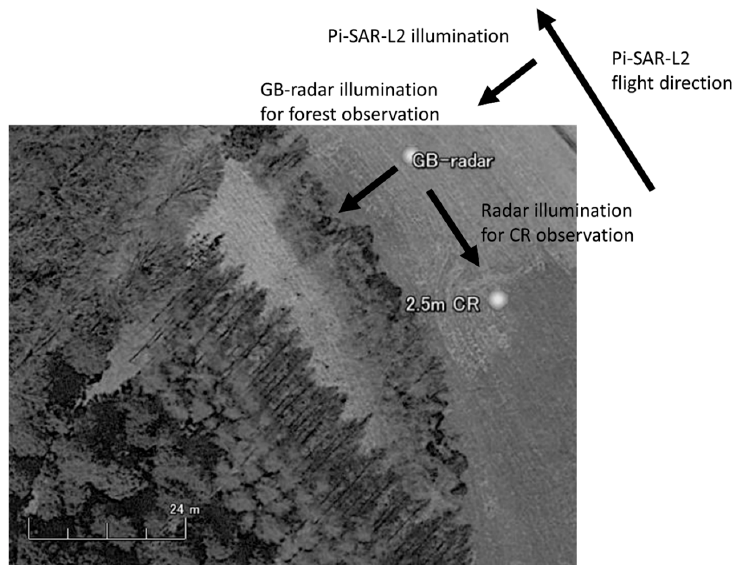
Figure 3. Configuration of the second field experiment.